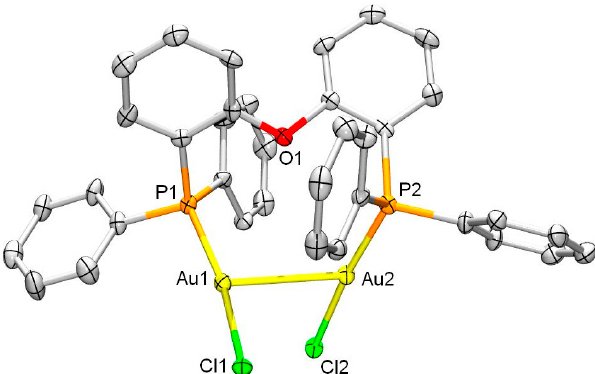
Figure 2. Displacement ellipsoid plots (50% probability level) of 2 . The disordered mixture of lattice CHCl 3 and acetone molecules in the asymmetric unit, as well as the hydrogen atoms, have been omitted for clarity. Selected bond lengths (Å) and angles (°): Au1–P1 2.2393(17); Au2–P2 2.2441(18); Au1–Cl11